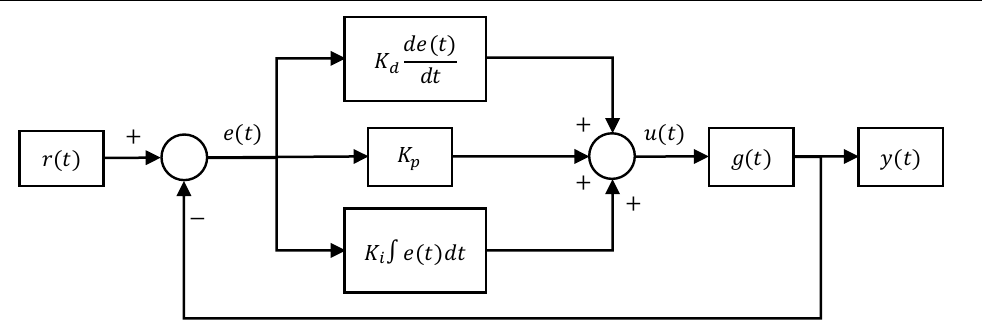
Figure 3. PID control block